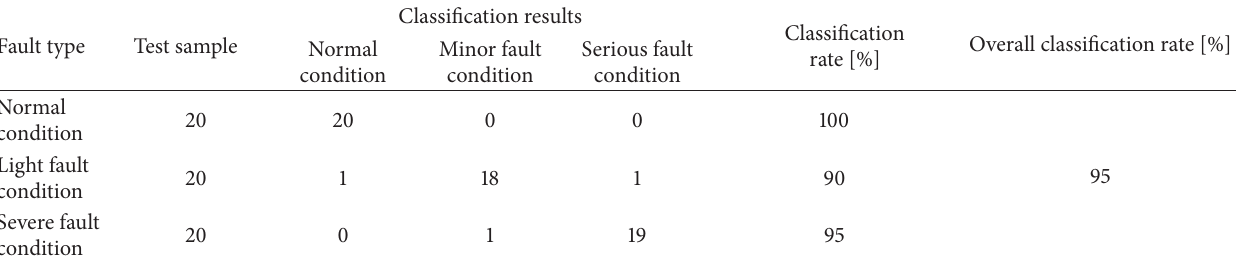
Table 3: Fault diagnosis using improved approach based on CEEMD and PE.